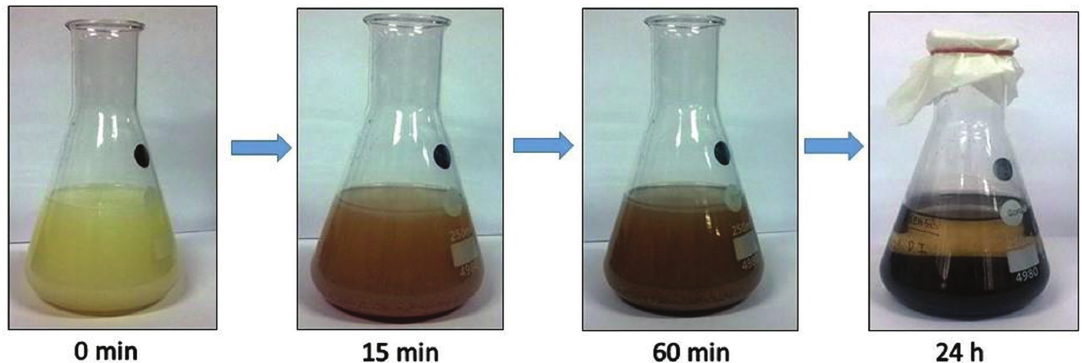
Figure 2: Colour change of reacting solution with